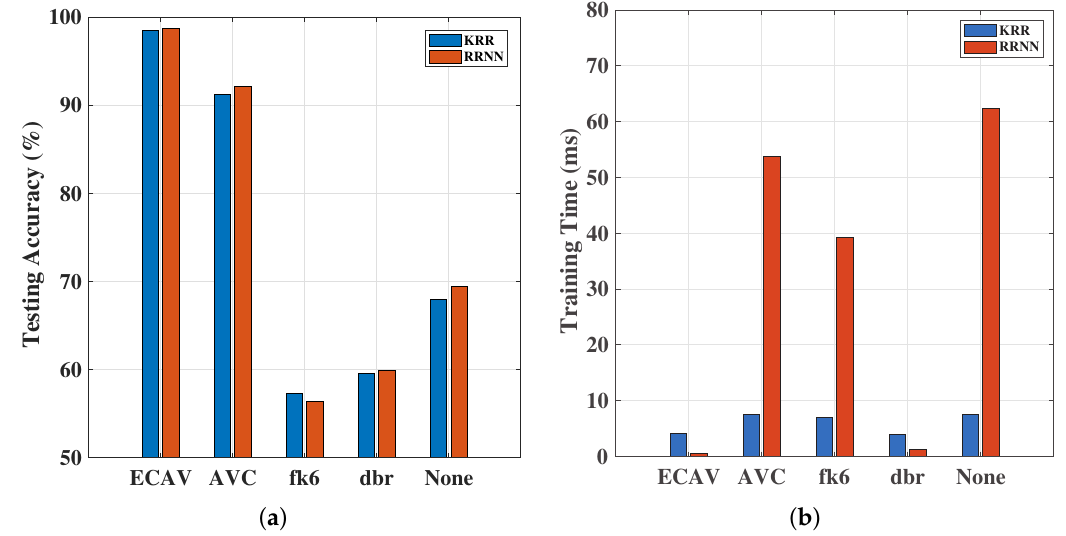
Figure 9. ( a ) Accuracy of the KRR and RRNN algorithms across different feature sets; ( b ) training time for the KRR and RRNN algorithms across different feature sets.